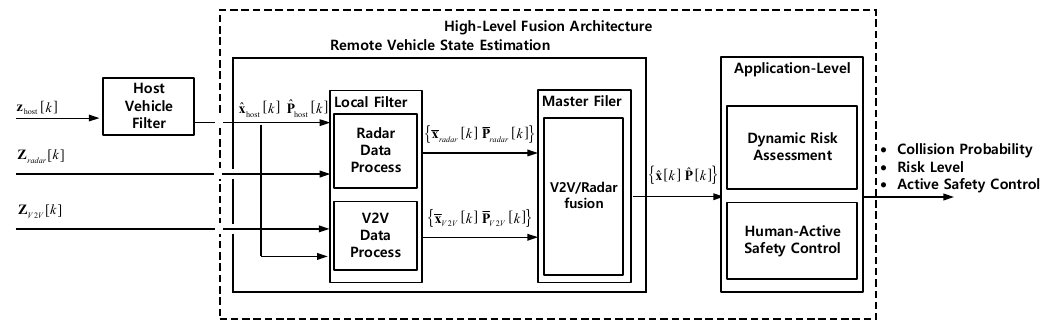
Figure 3. High-Level Information Fusion Architecture.